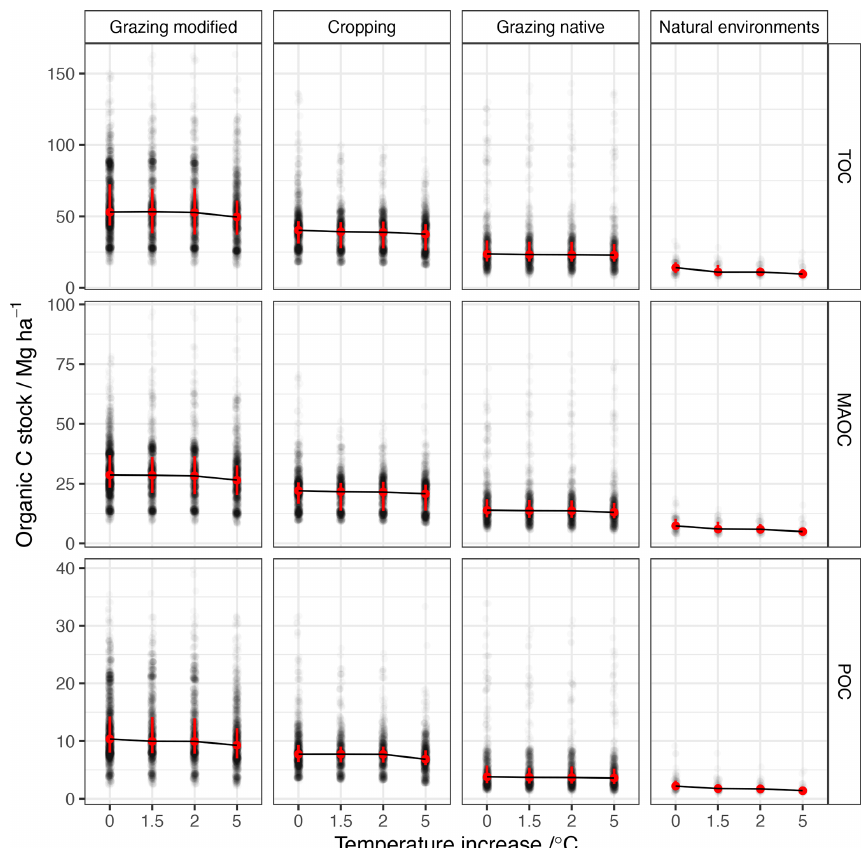
Figure 6. After 100-year simulations, differences in total organic C stock under a warming climate, showing median values and the 10th and 90th quantiles. A changing climate is represented by adding 1.5, 2 and 5 ◦ C to the baseline temperatures (1991–2010) and then repeating over the 100-year period.